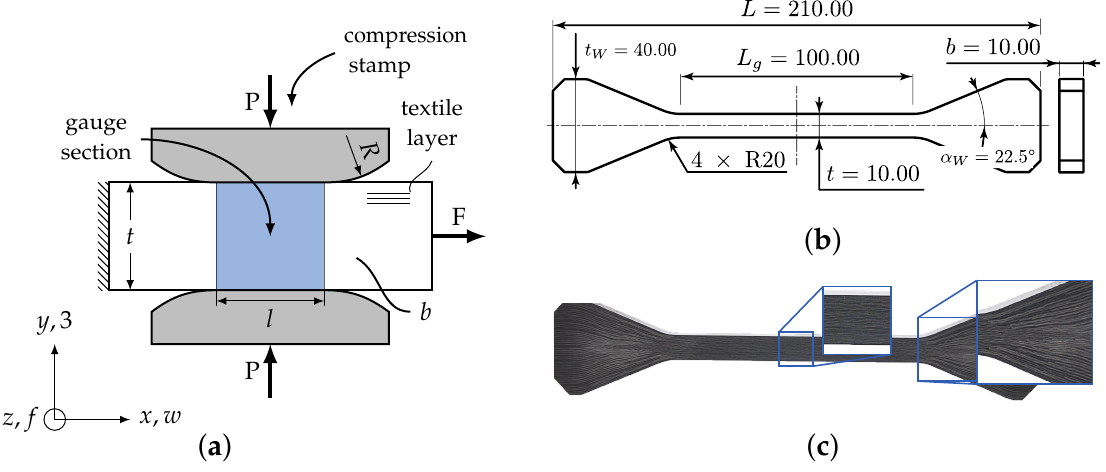
) -testing for textile-reinforced composites: ( a ) schematic test set-up and Figure 3. Elaborated ( σ t w / σ c 3 global and material CS, ( b ) technical drawing with characteristic dimensions in (mm) and ( c ) specimen and magnification of wedge clamping section and gauge